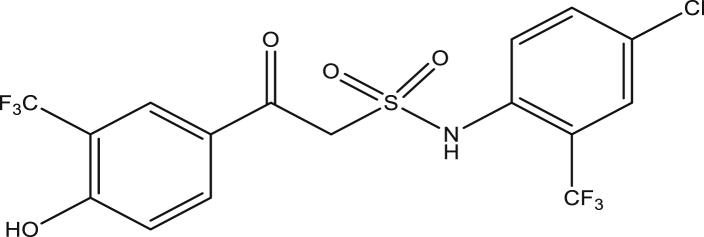
Compound 9b[N-(4-chloro-2-(trifluoromethyl)phenyl)-2-(4-hydroxy-3-(trifluoromethyl)phenyl)-2-oxoethanesulfonamide (pEC500.1670010)].